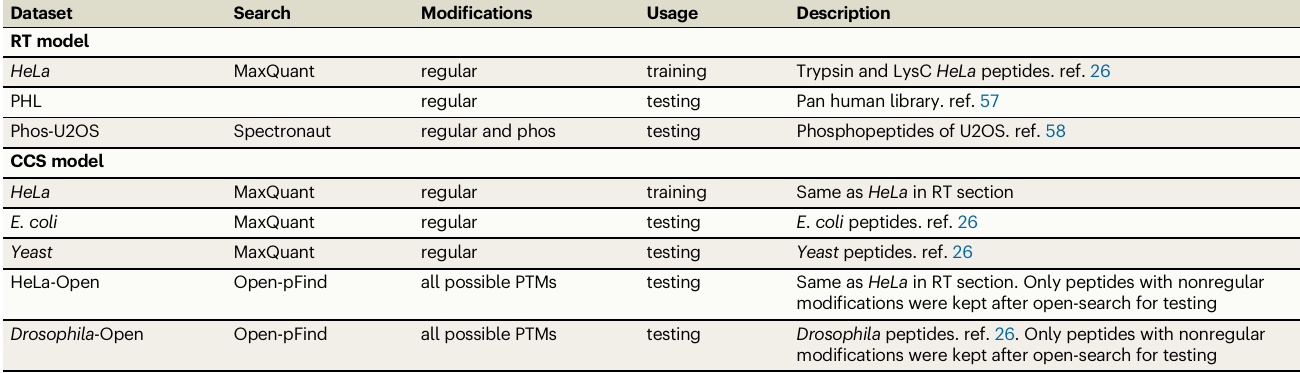
Table 1 | Dataset information used to train and test RT/CCS